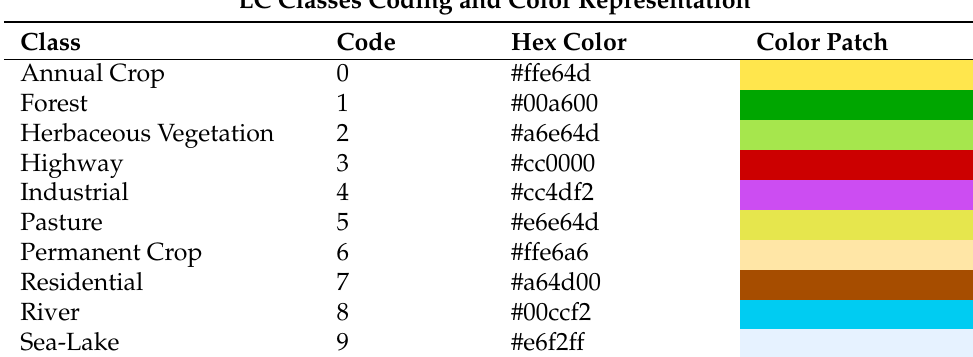
Table 2. Definition of land cover classes for